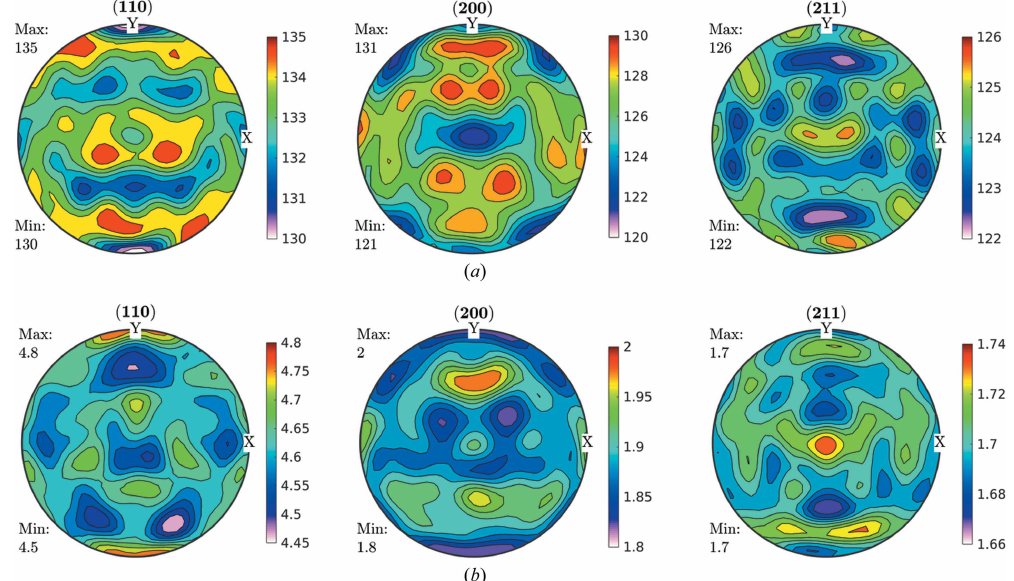
Figure 14 Recalculated GPFs for ( a ) domain size (nm) and ( b ) dislocation density (10 14 m (cid:3) 2 ), as separated by following the Langford model from FWHM GPFs. Heat-treated sample, 5 s at 730 (cid:6)